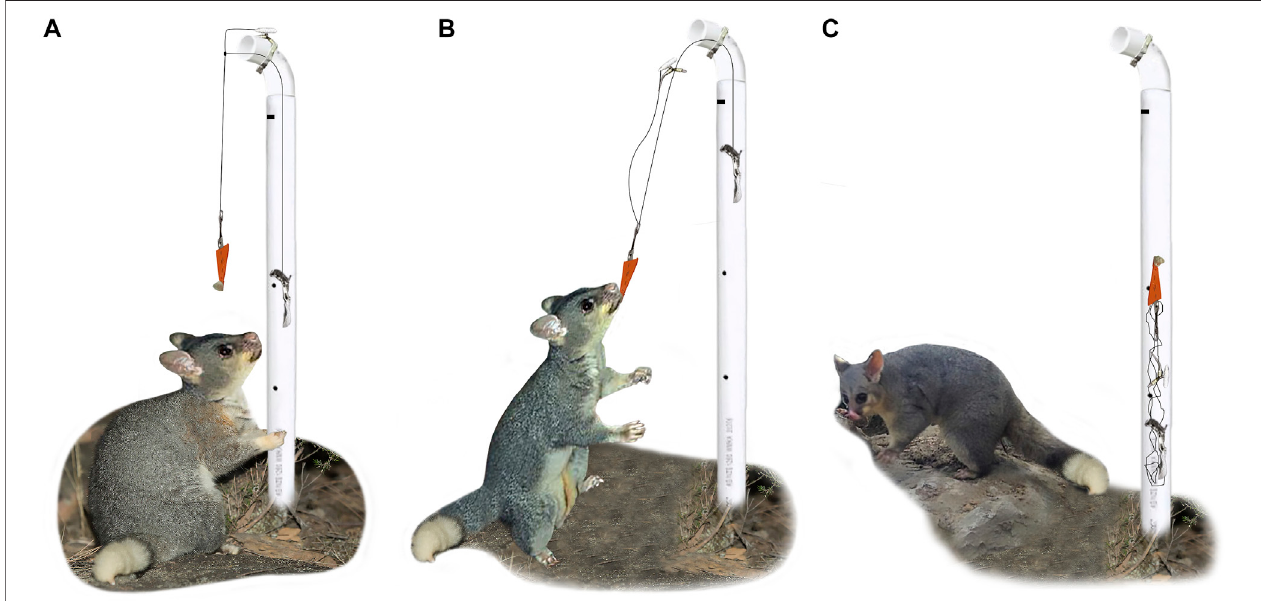
FIGURE2| SequenceofeventsresultinginsamplecollectionbytheDNAcollectiondevice; (A) theanimalinspectsthedevice, (B) bitesintotheWaxTag ® attached tothebaiter(orange)andpullsthemagnetawayfromthemetalband, (C) gravitypullsthesinkerintothecentralhousingunitandthecollectedDNAisprotectedwithinthe shaft of the apparatus (for more details see Supplementary Figures S2, S3 ).